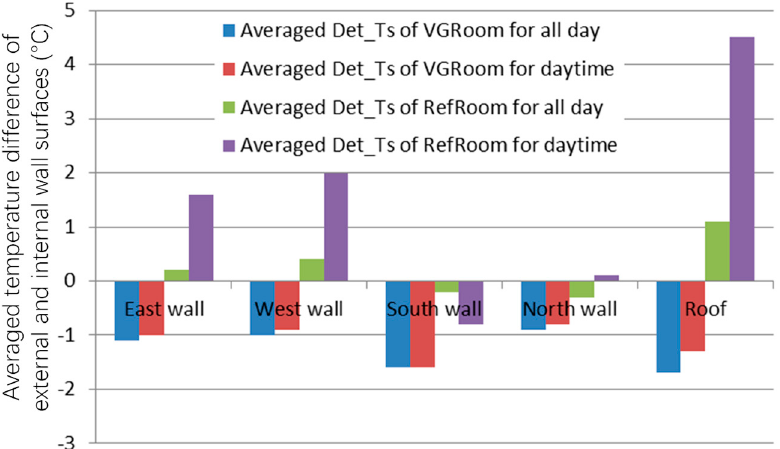
Figure 18. Average temperature differences of external and internal surfaces of the walls and roof.